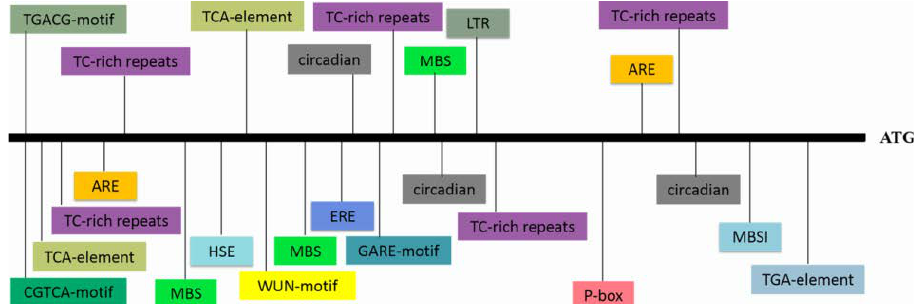
Figure 1. Phylogenetic relationship and conserved domain analysis of IbWRKY2. ( a) Phylogenetic analysis of IbWRKY2 and 71 WRKY transcription factors from Arabidopsis . Roman numerals indicate different subfamilies of WRKY proteins and the black dot in the phylogenetic tree indicates IbWRKY2. ( b ) Amino acid sequence alignment of IbWRKY2 with homologs from NCBI. The conserved WRKY Figure 2. The types and locations of cis -acting elements present in the IbWRKY2 promoter region. The domains are marked by black lines. promoter region, which is 2381 bp upstream of the initiation codon, was used for the analysis. Differently colored boxes represent different cis -acting elements. ATG indicates the start codon of IbWRKY2 .